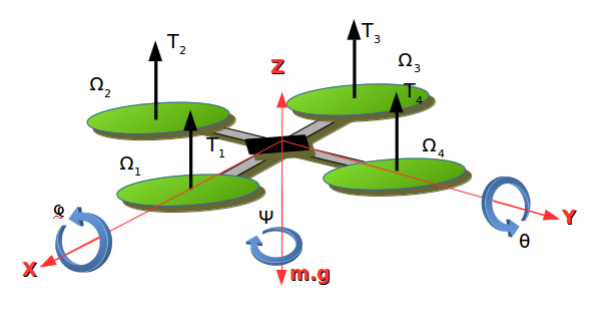
Figure 4. Dynamics involved in the quadcopter